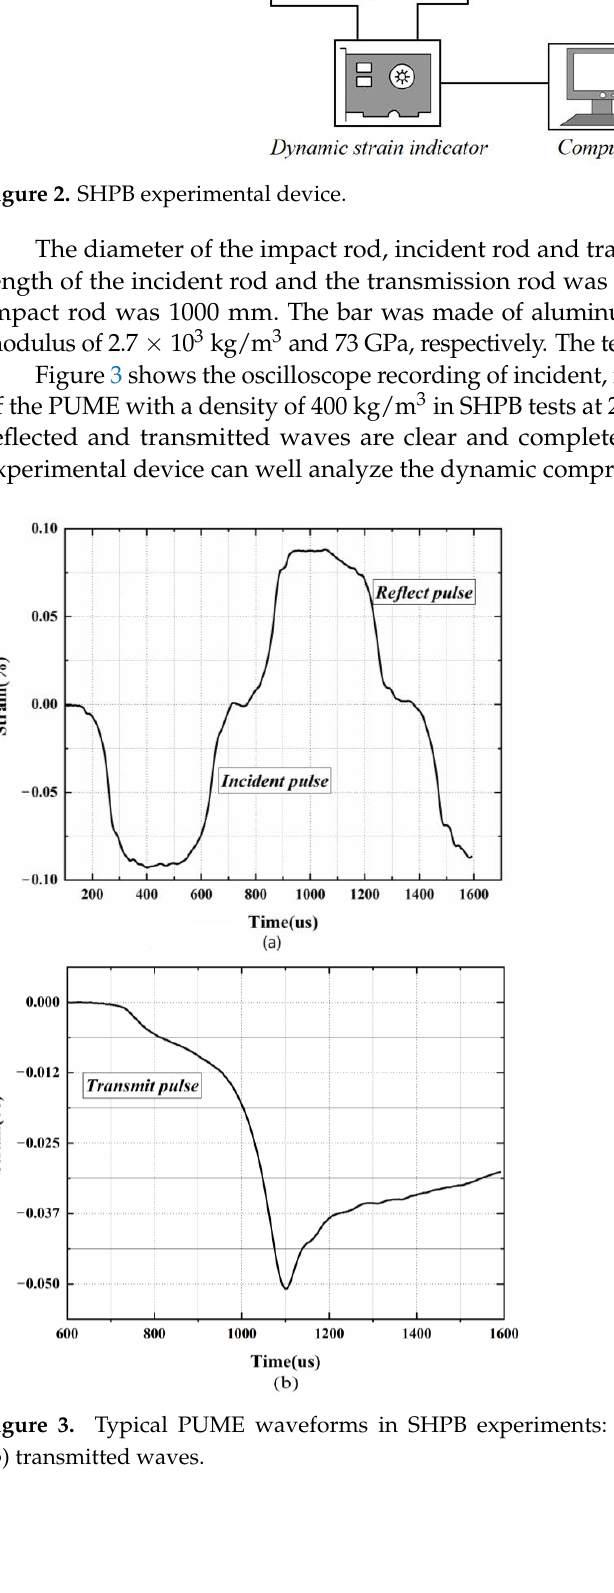
Figure 2. SHPB experimental device.